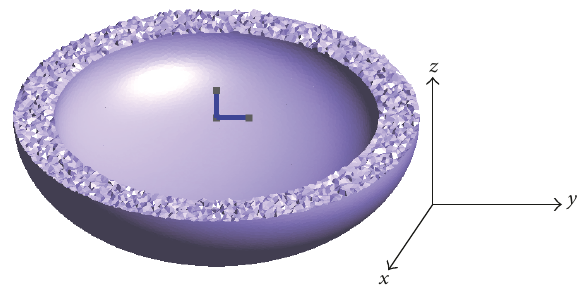
Figure 5: Sectional view grid.